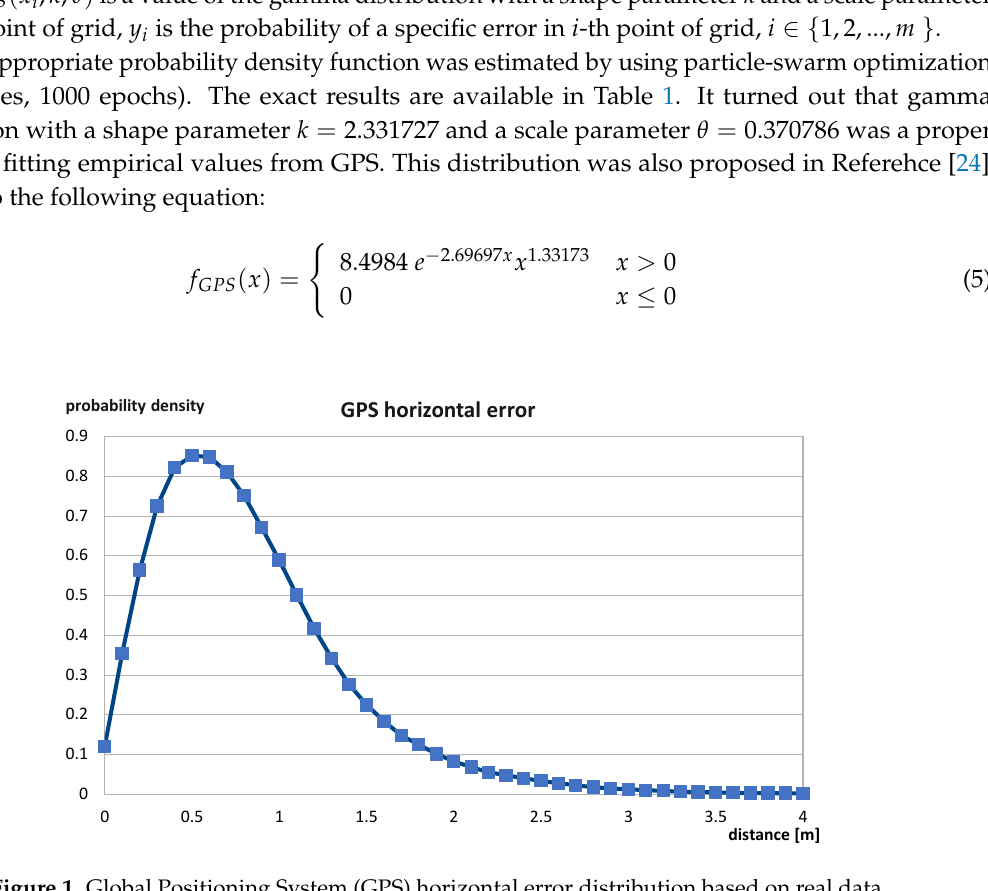
Figure 1. Global Positioning System (GPS) horizontal error distribution based on real